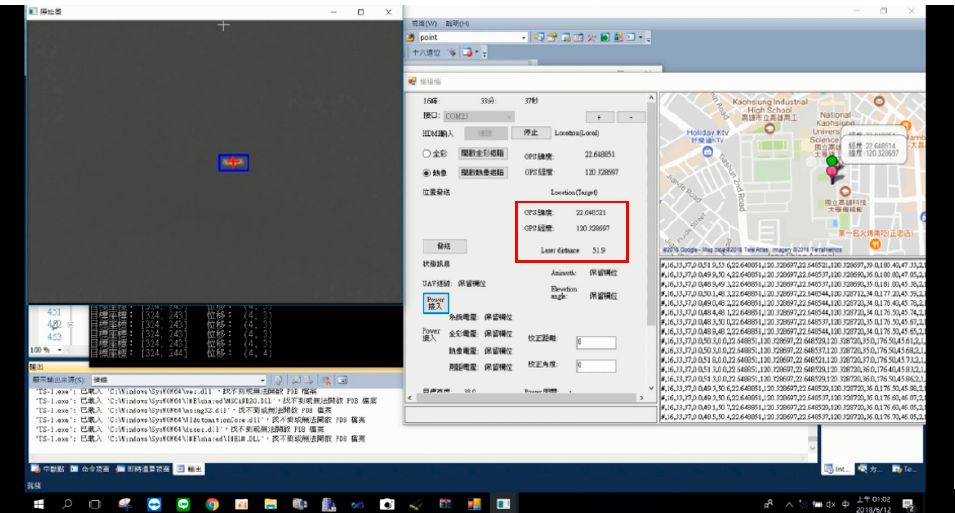
Figure 18. Test results of thermal imaging tracing interface.